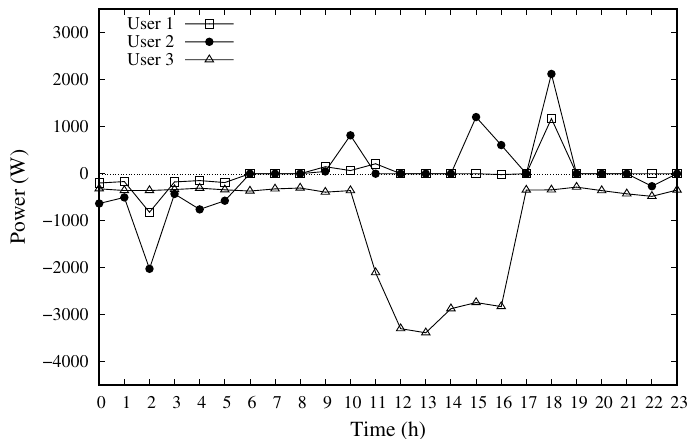
Figure 3. Daily profile of the three users with the Separated model.